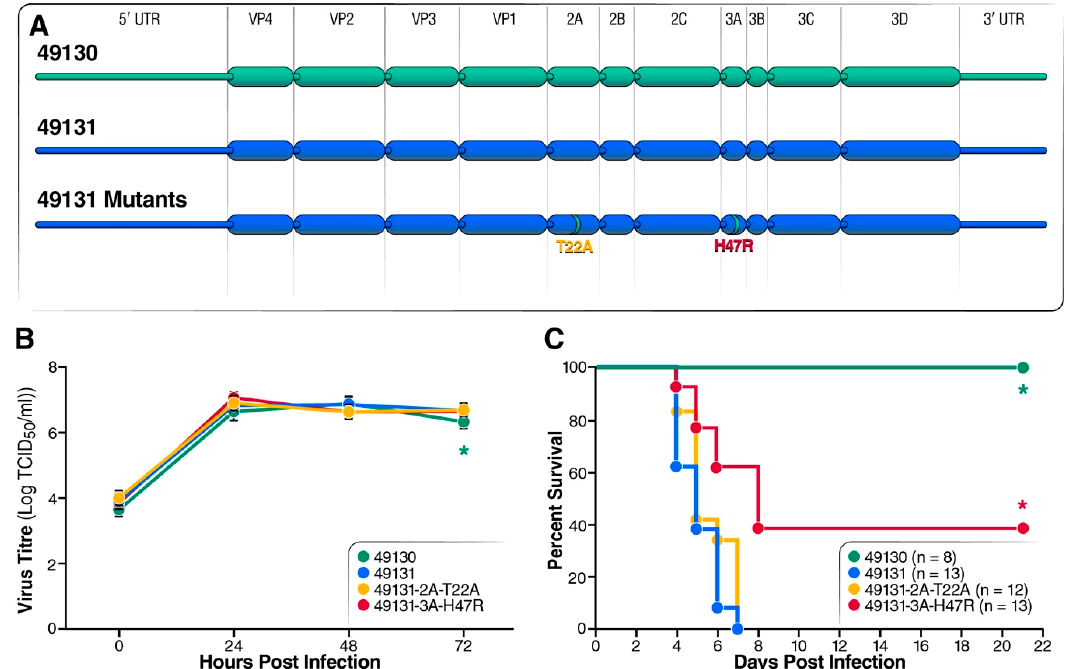
Figure 4. Validation of genetic changes in the non-structural genes on EV-D68 virulence with strain 49131 as a backbone. ( A ) Schematic of the gene-swapped and point-mutated viruses. Strain 49131 was used as backbone to generate these recombinant viruses. Amino acid changes 2A-T22A and 3C-H47R were introduced into 49131 individually. ( B ) Replication analysis for the engineered EV-D68 viruses carrying mutations in the non-structural region (NSR) was performed with RD cells, as described in Figure 1B. Results of triplicates are shown as mean ± S.D. Asterisk: significantly lower virus titer of 49130 at 72 h post infection comparing with 49131 was detected by Student’s t test ( p < 0.05). ( C ) Seven-day-old mice were i.p. inoculated with 1 × 10 5 TCID 50 of viruses carrying 2A-T22A or 3C-H47R and monitored for 21 days. 49131, 2A-T22A, and 3C-H47R were tested in 2 litters of pups. Asterisks represent survival curves which, compared with those of 49131-infected mice, were determined to be significantly different by using log-rank test ( p < 0.05).